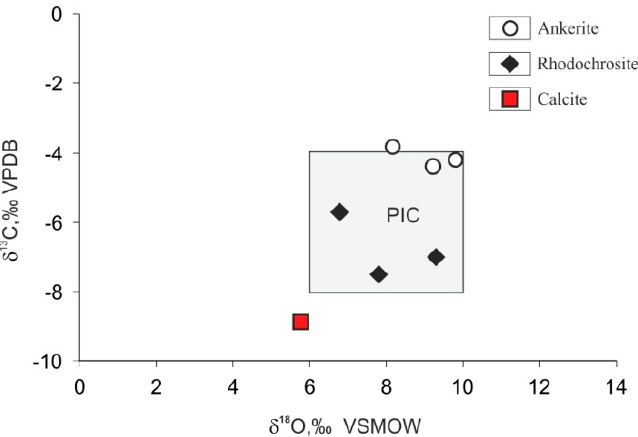
Figure 3. Diagram of the δ 18 O vs. δ 13 C values for carbonates from the Kholtoson deposit. PIC—primary igneous carbonatite field after Reference [50], Taylor et al., 1967.